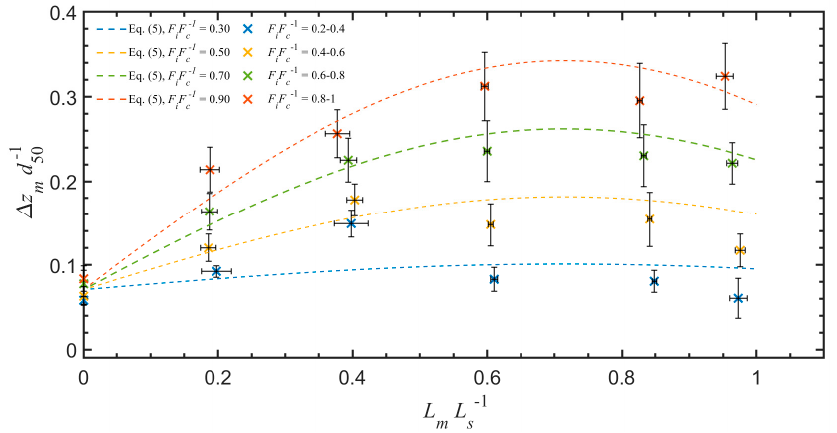
Figure 11. Observed 2D stone displacements from Figure 10 with predicted values from Equation (5) in dotted lines. The average normalized stone displacements are displayed along the z -axis ( Δ (cid:3053) ) and along the x -axis ( L m L − 1 s ). The displacements are presented for incremental normalized load values ( F i F − 1 c ) during overtopping and the uncertainties are displayed according to 95% confi- dence intervals.